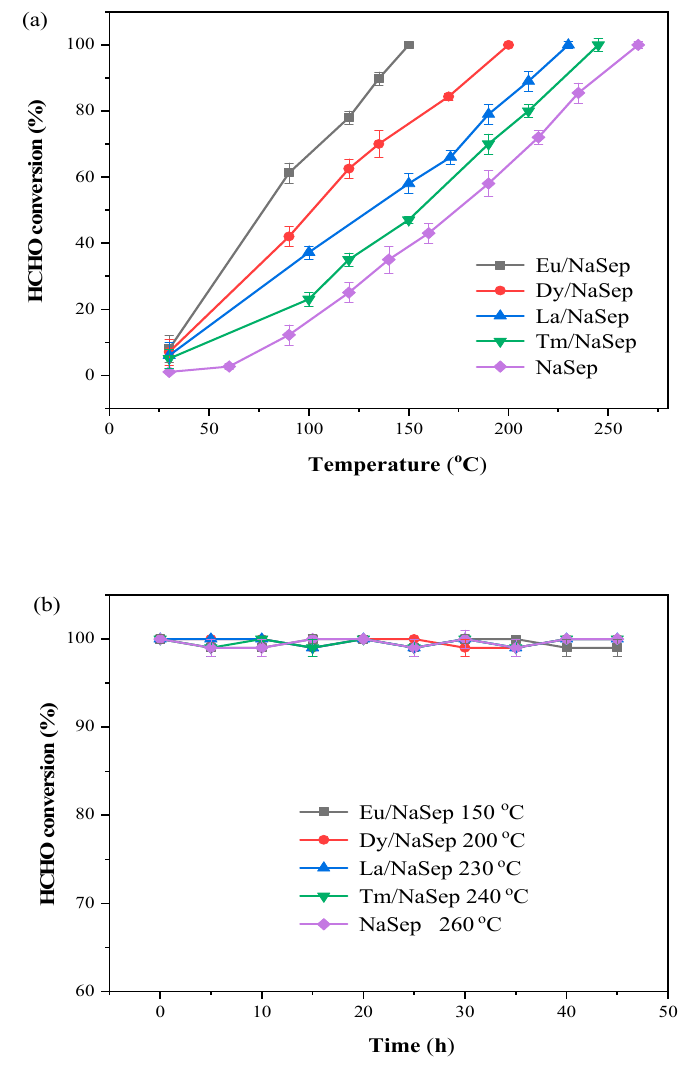
Figure 8. ( a ) HCHO conversion as a function of temperature and ( b ) HCHO conversion versus reaction time over the samples under the conditions of 2000 ppm HCHO + 20 vol % O 2 + N 2 (balance) and GHSV = 240,000 mL/(g h). Table 4. A comparison on specific reaction rates ( r cat ) of formaldehyde (HCHO_ oxidation at 100 ◦ C over the catalysts studied in the present work and reported in the